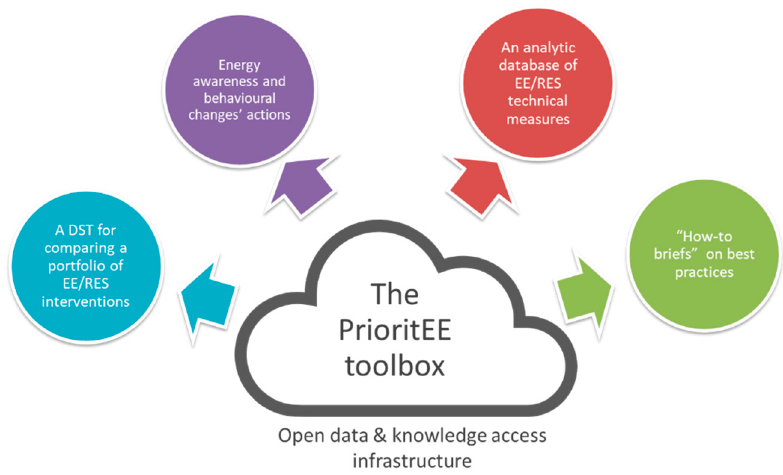
Figure 1. Main components of the PrioritEE Toolbox.